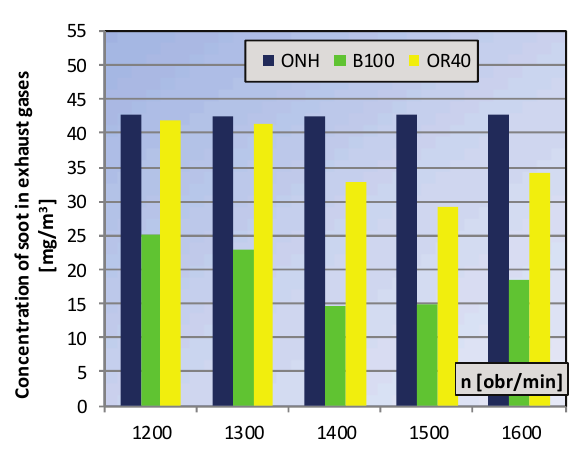
Fig. 9. Concentration of soot in exhaust gases for test engine performance